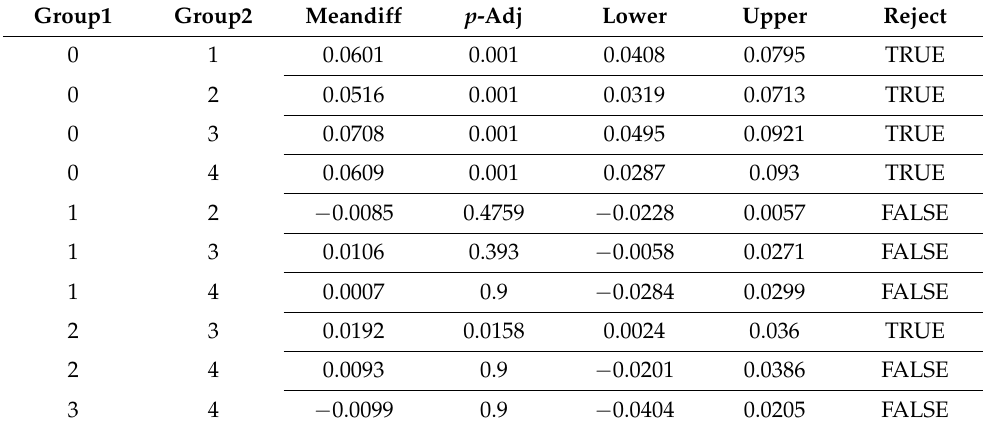
Table 3. Tukey’s honest significant difference of comparisons among watershed distance classes.